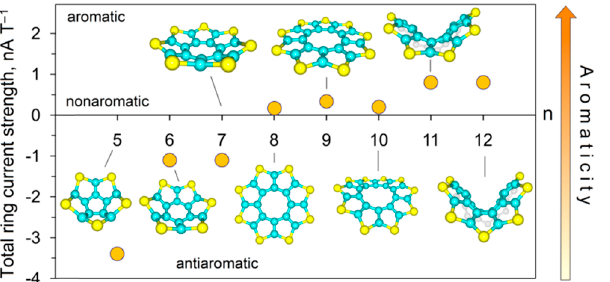
Figure 16. The dependence of the magnetically induced current strength on the increase in the number of conjugated thiophene rings ( n ) in a molecule [95].